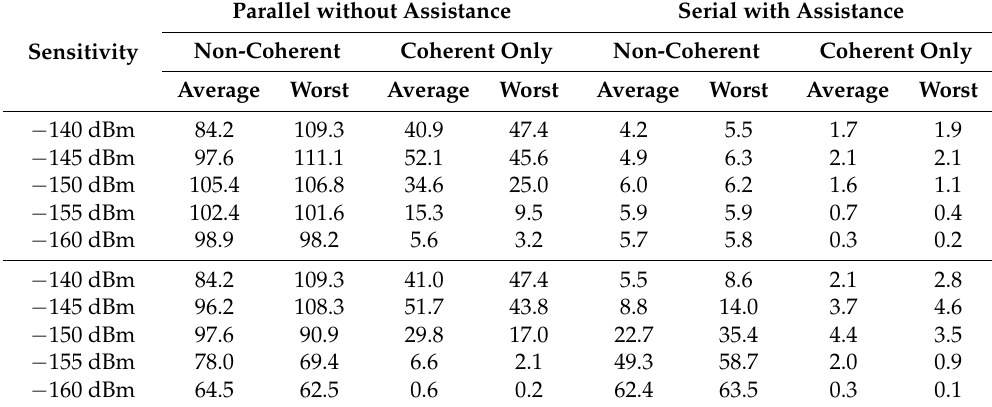
Table 10. Ratio of complexity (product of processing time ratio and memory ratio) between the L5 and L1 C/A signals. Top rows do not consider the input memory, while bottom rows consider the input memory.